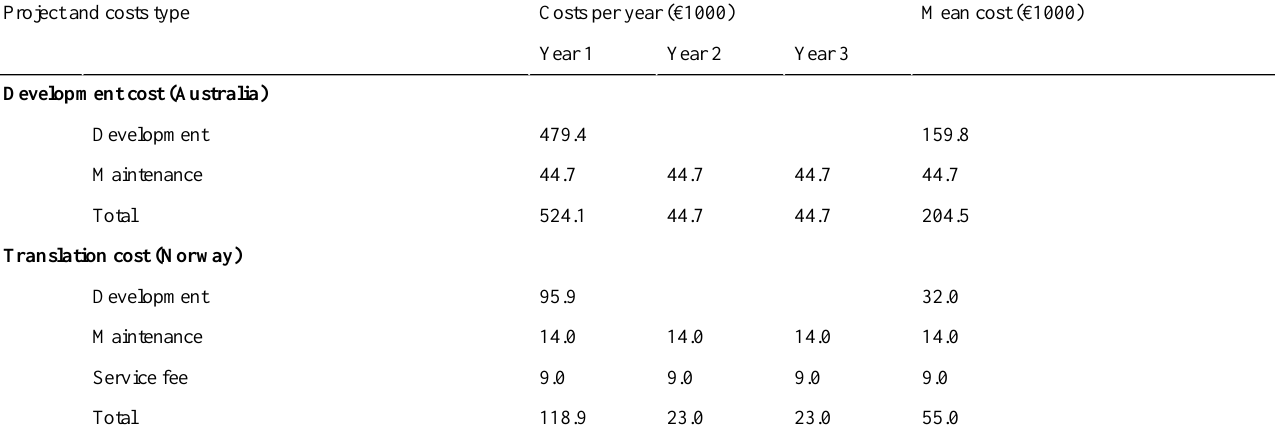
Table 6. Estimated development and translation costs with mean cost (based on 3 years’operating